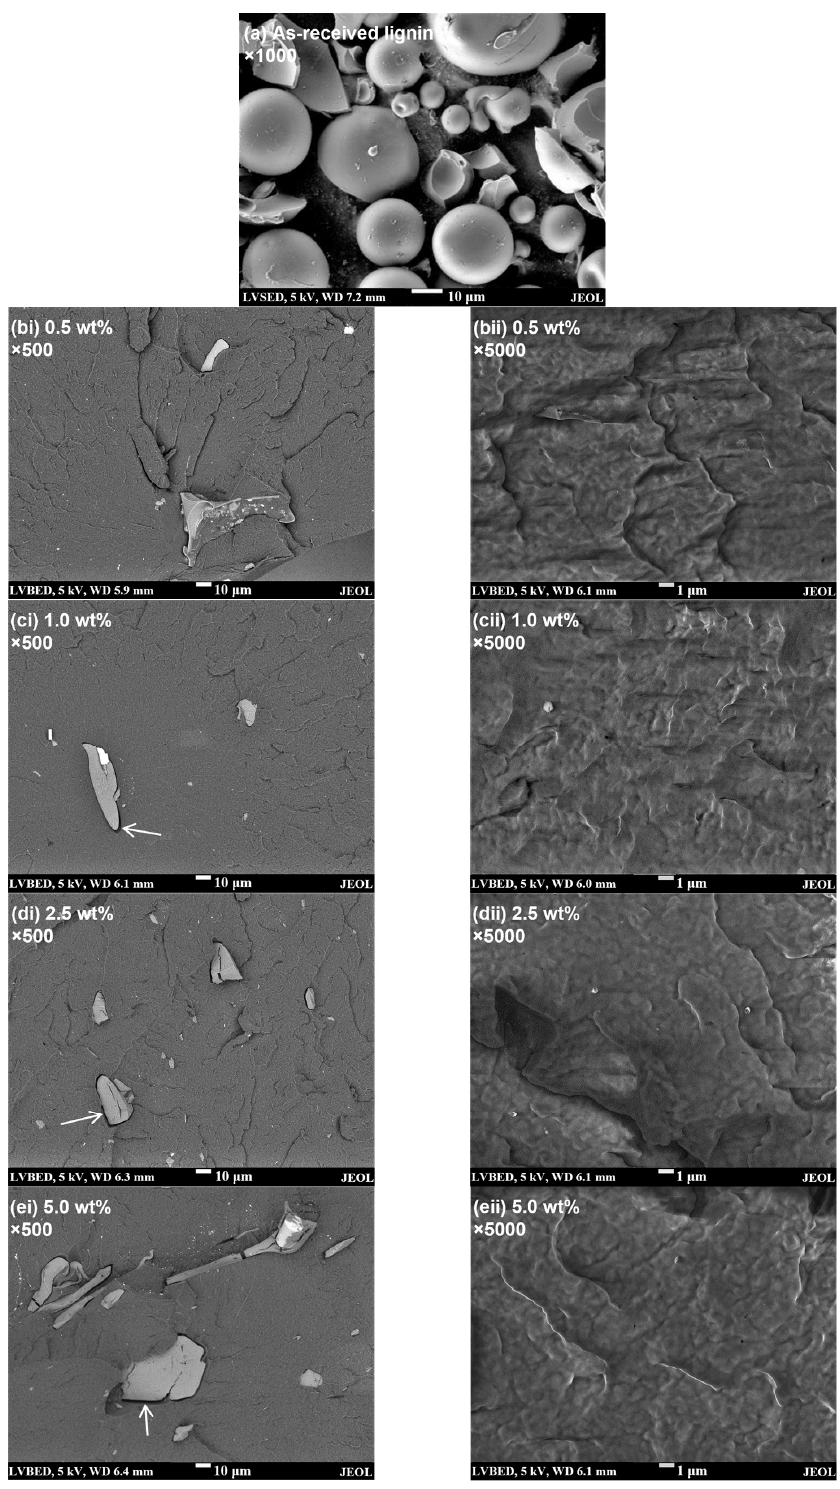
Figure 1. Typical SEM images showing ( a ) as-received lignin powder, and fractured cross-section surfaces of as-compounded PP/lignin composites with ( b ) 0.5, ( c ) 1.0, ( d ) 2.5, and ( e ) 5.0 wt% of lignin at ( i ) low magnification and ( ii ) high